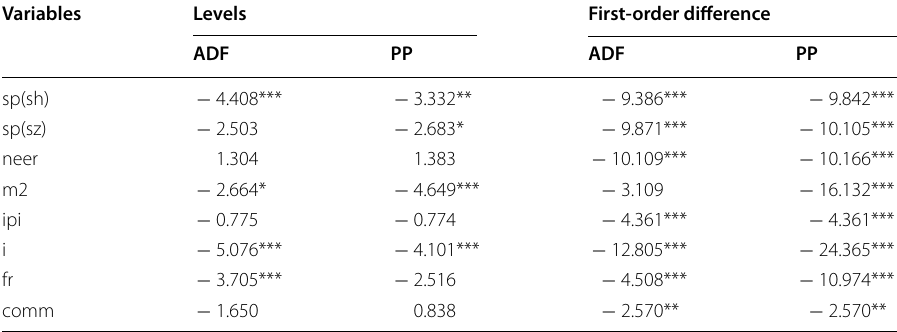
Table 1 ADF unit root and pp stationarity tests